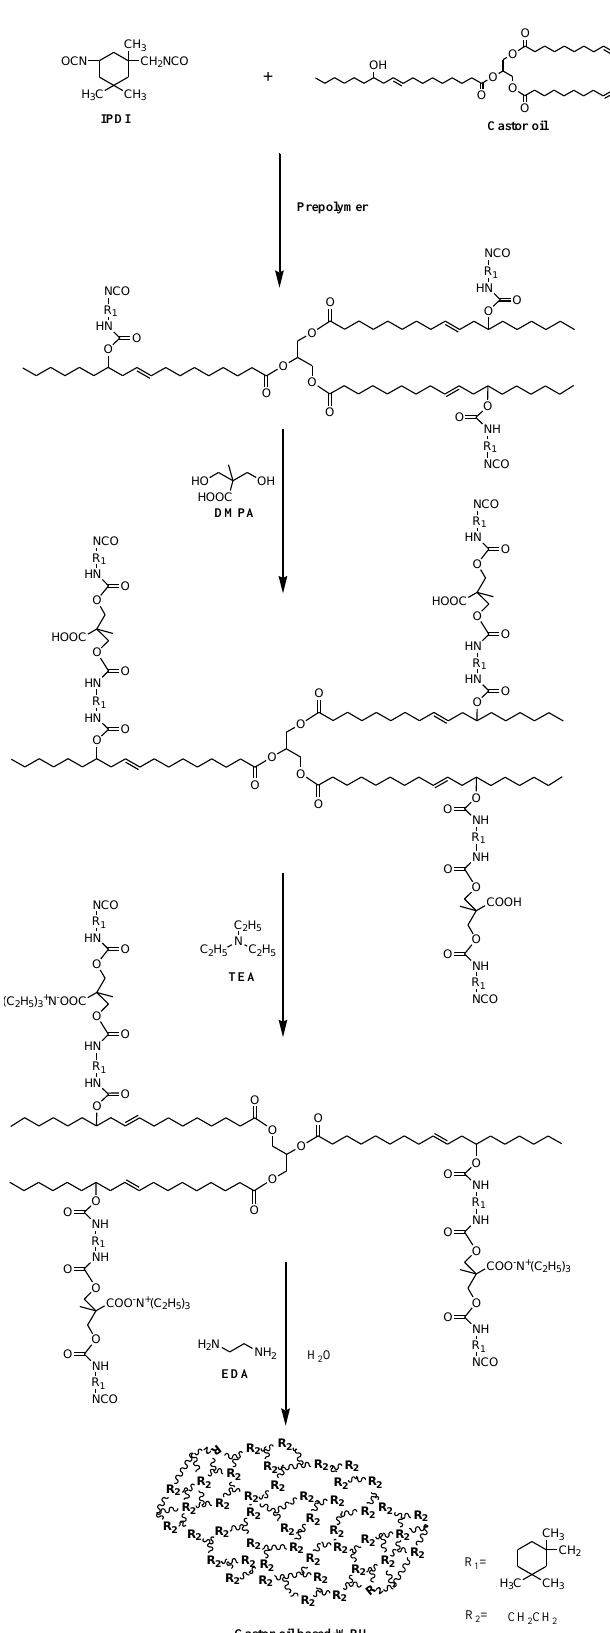
Scheme 1. Formula for the castor oil based-WPU.